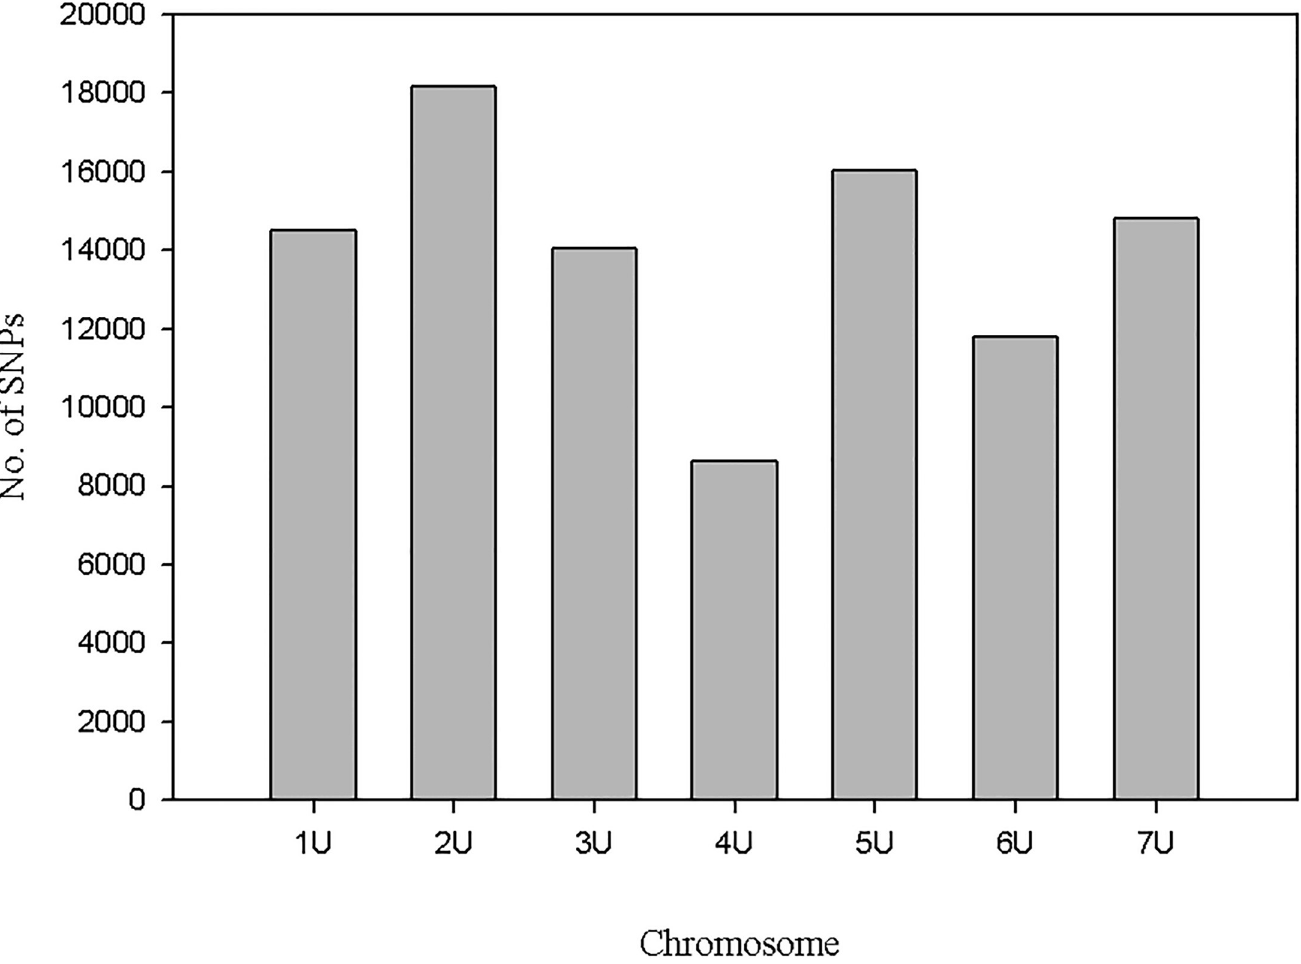
Fig 8. Distribution of SNPs identified from susceptible parent’s assembly with de novo approach on Ae tauschii chromosomes.